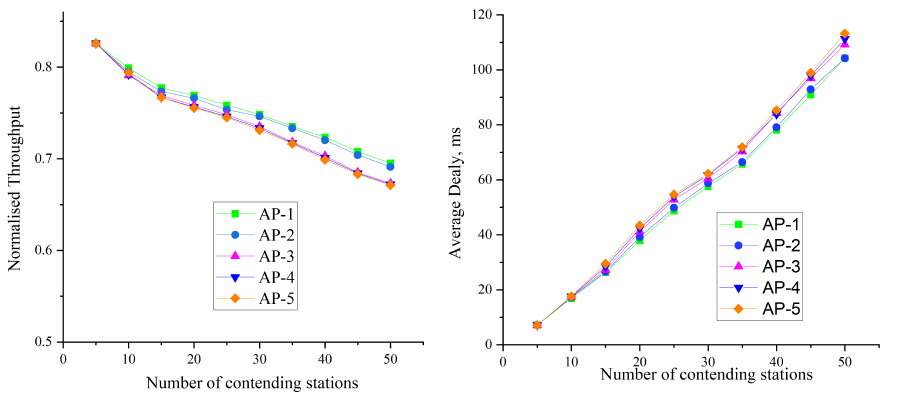
Figure 12. Scalability analysis of the CWSB mechanism for multiple APs.